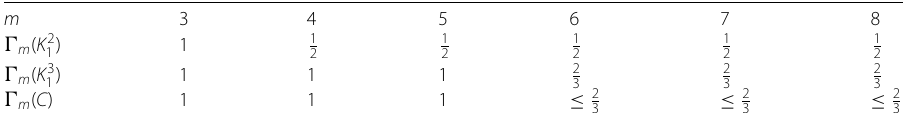
Table 2 Exact values of (cid:3) m ( K 2 Theorem 6 for (cid:3) m ( C ) with C = K 3